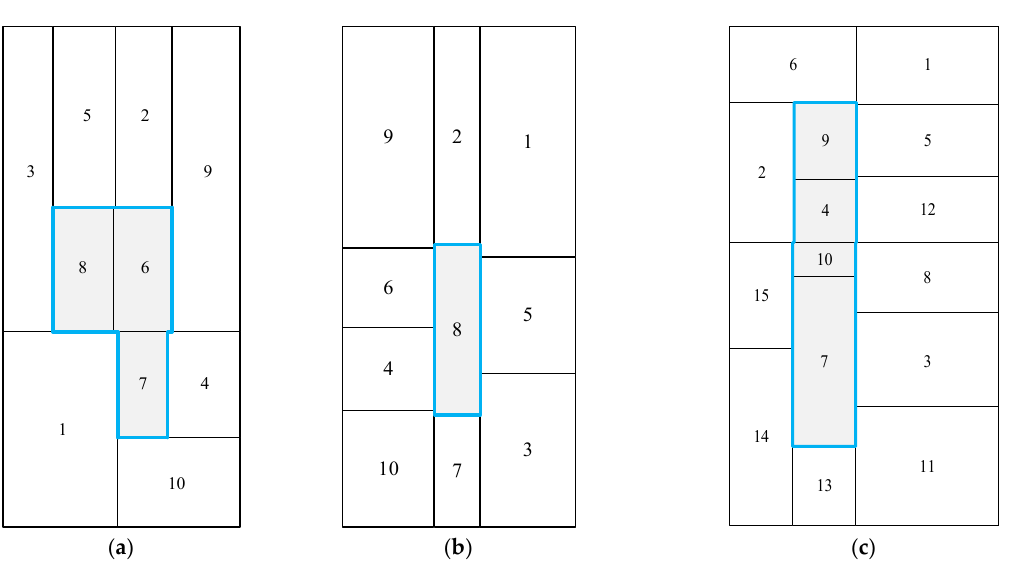
Figure 13. Layout configurations. ( a ) vC10s; ( b ) vC10a; ( c ) KC15.